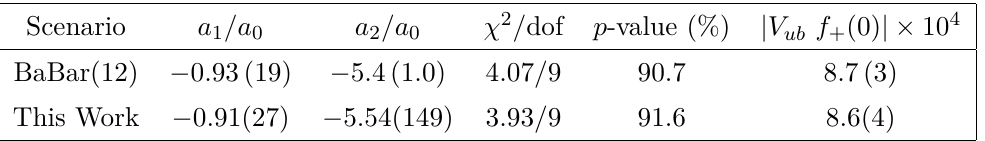
Table 4 . Comparison between fit-results with only the experimental data (combined) between BaBar (12) [8] and us. We have reproduced the (combined) fit of table V I of the same reference. q 2 (GeV 2 ) − 15 − 10 − 5 0 5 f + (cid:0) q 2 (cid:1)